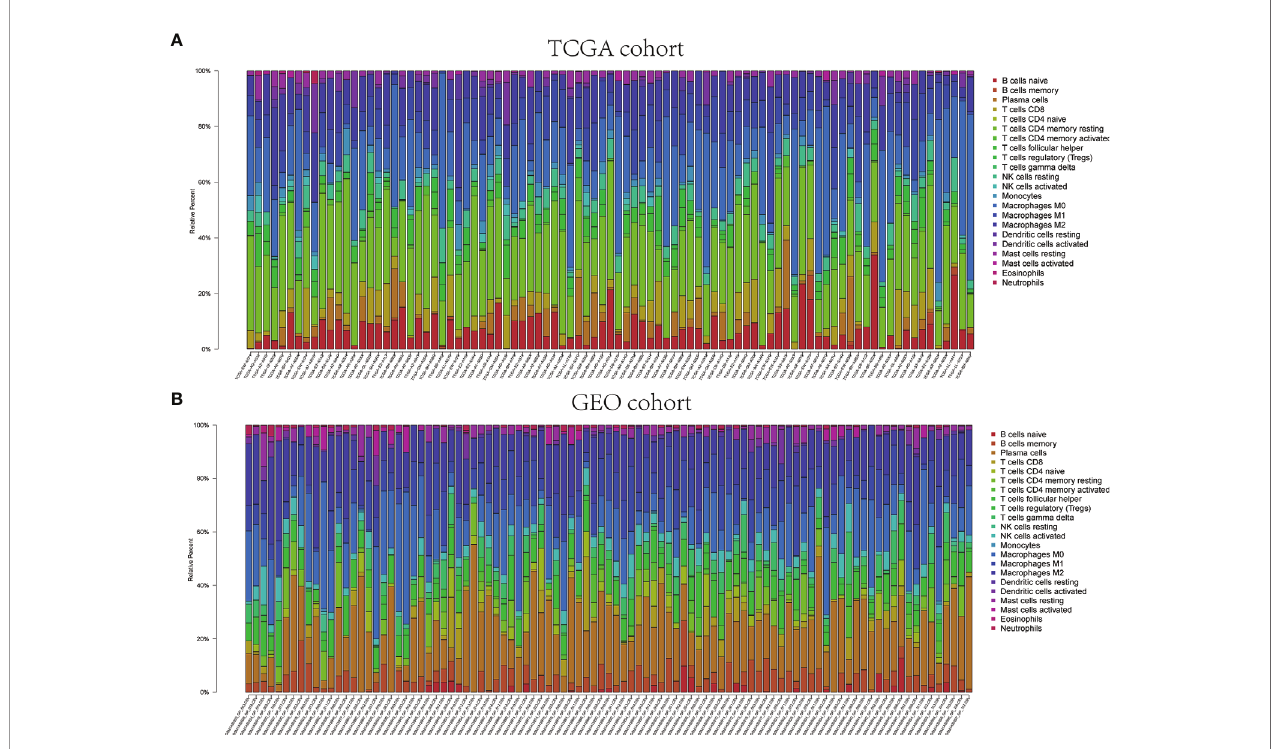
FIGURE 10 | Immune in fi ltrations of TCGA and GEO cohorts. Relative proportion of immune in fi ltration in TCGA (A) and GEO (B)